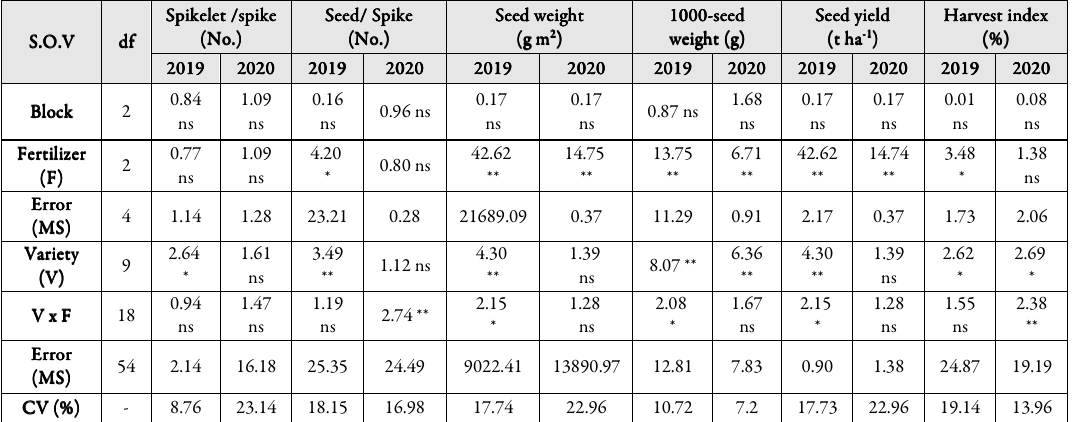
Table 5. Analysis of variances (F) for the effect of fertilization and different wheat varieties on reproductive